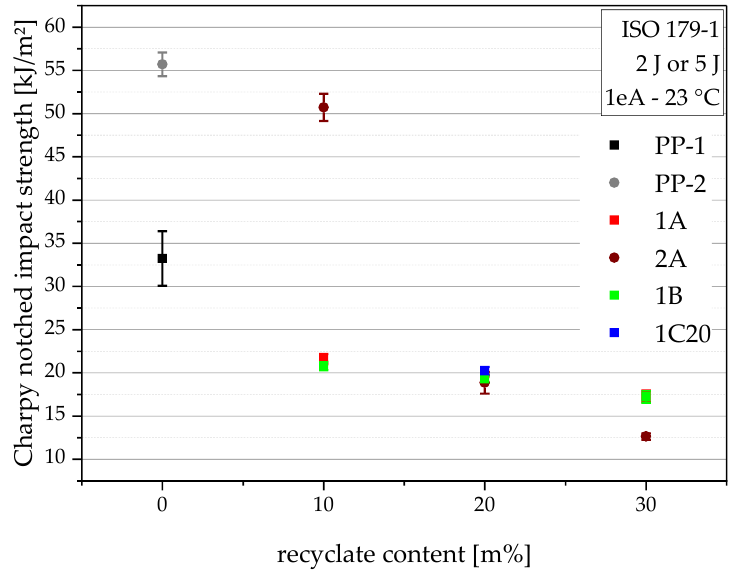
Figure 9. Graphical illustration of Charpy notched impact strength of the virgin blending partners PP-1 and PP-2 (as 0 m% recyclate content data points) and all compounds. The vertical bars show the sample standard deviations.